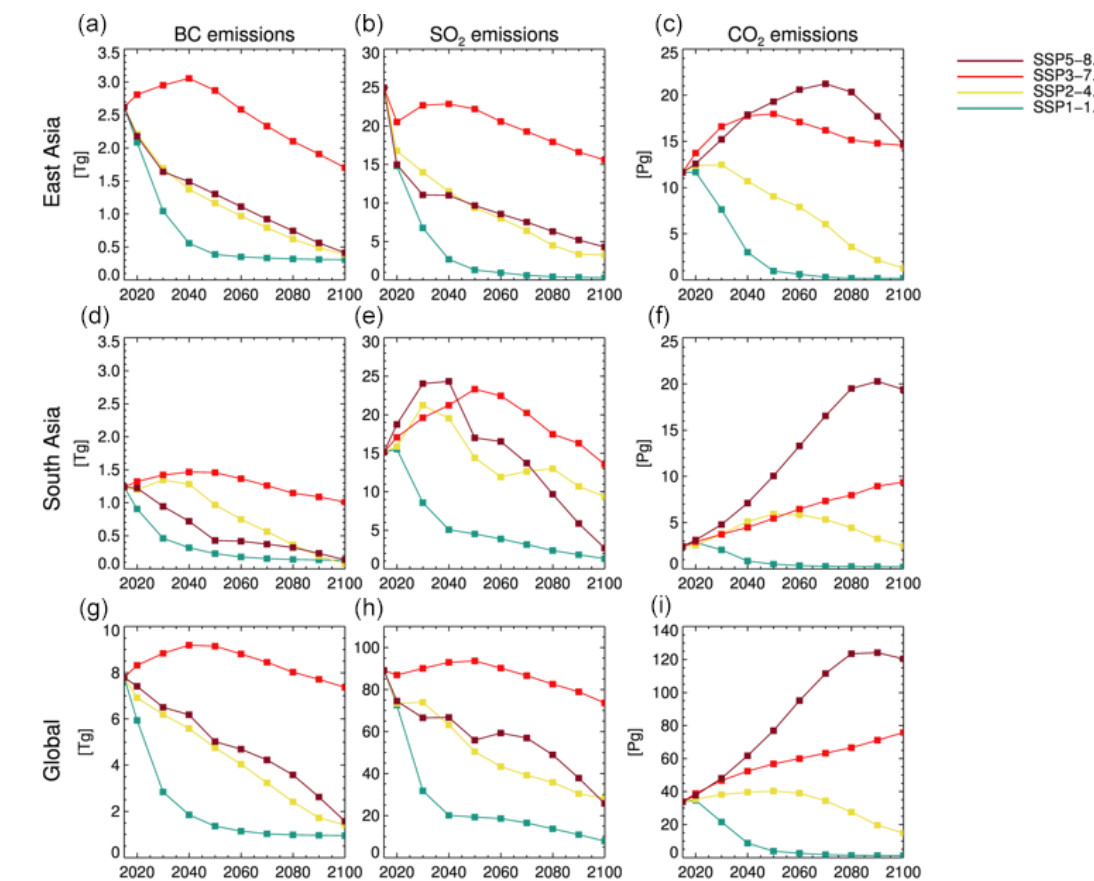
Figure 1. (a) Black carbon (Tg), (b) sulfur dioxide (Tg), and (c) carbon dioxide emissions (Pg) over East Asia for SSPs 1-1.9, 2-4.5, 3-7.0, and 5-8.5. (d–f) Emissions over South Asia. (g–i) Global total emissions. East Asia is the region 20–40 ◦ N and 100–120 ◦ E. South Asia is the region 5–25 ◦ N and 55–95 ◦